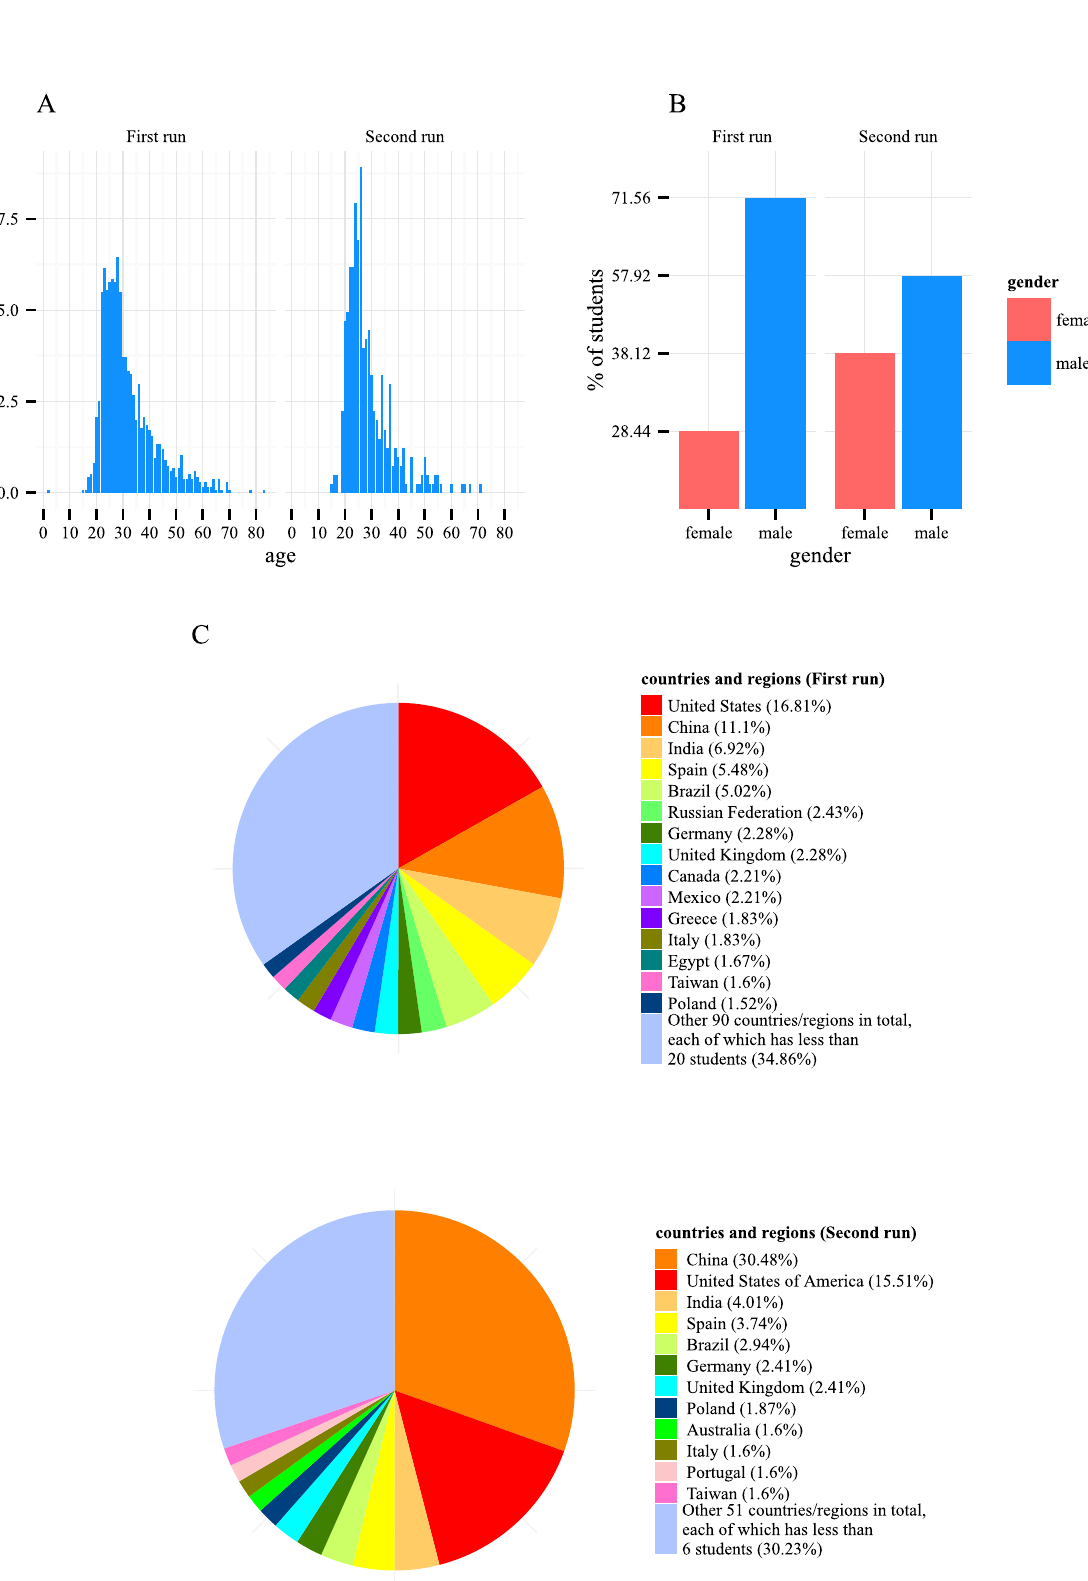
PLOS Computational Biology |